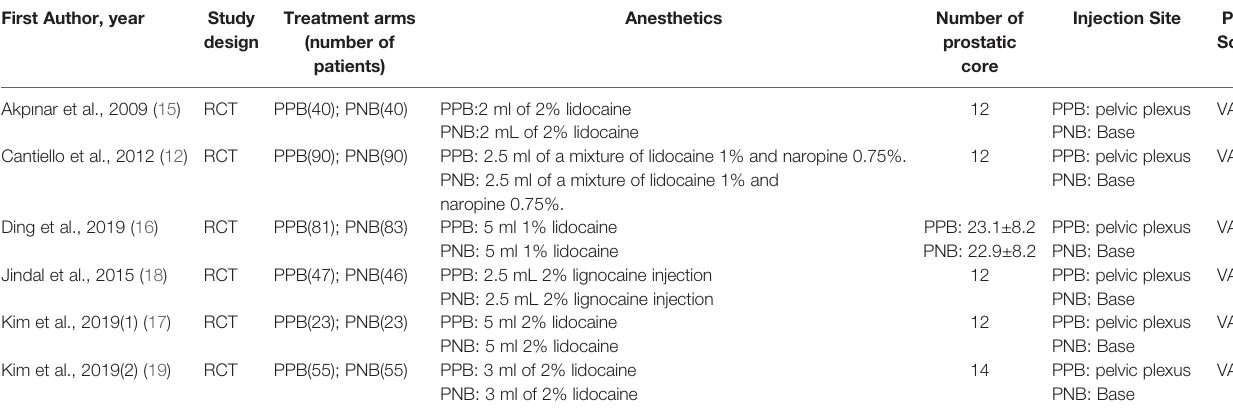
TABLE 1 | The main characteristics of included studies.